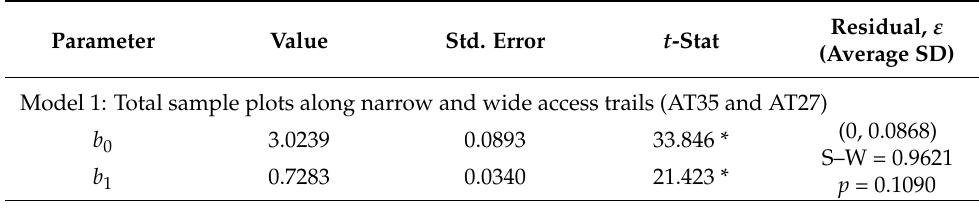
Table 7. Linear regression analysis of mini-harvester productivity (Equation (1)) with an Arbro 400 S head as a function of average stump